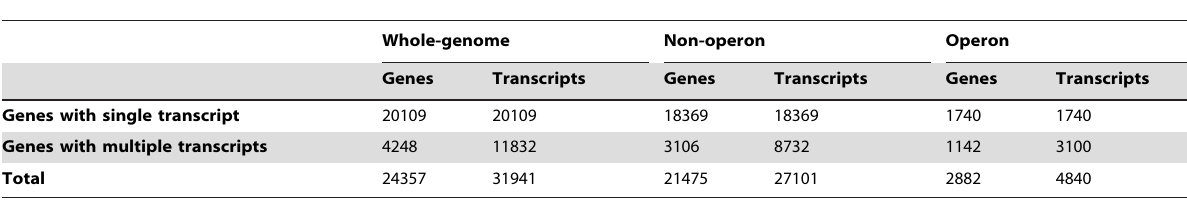
Table 1. The numbers of genes and transcripts we analyzed.